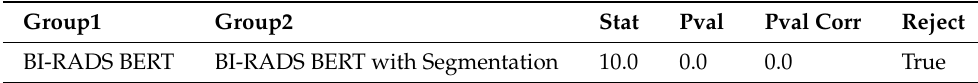
Table A22. McNemar test results for field extraction of modality.